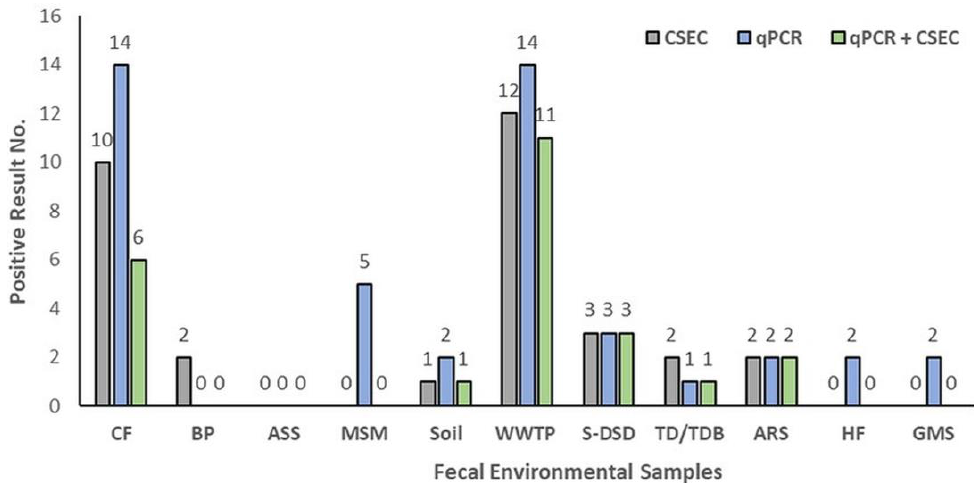
Figure 2. Comparison of detection results of environmental C. difficile between qPCR and C. difficile selective enrichment culture (CSEC). CF: calf feces; BP: biogas plant; ASS: activated sewage sludge; MSM: mixed storage manure; S-DSD: digested sludge-amended soils; TD/TDB: thermophilic digest-